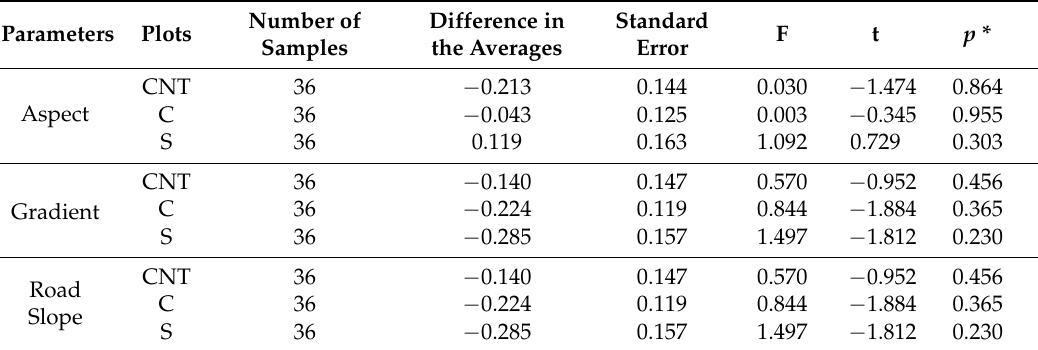
Table 4. Results of t -test for other parameters in plots with transported suspended